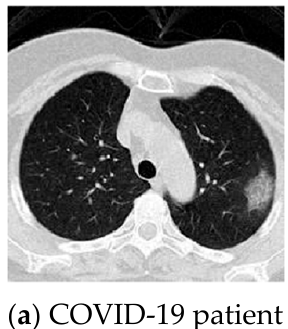
Figure 2. Illustration of the COVID-19 dataset ‘COVID Academic’.